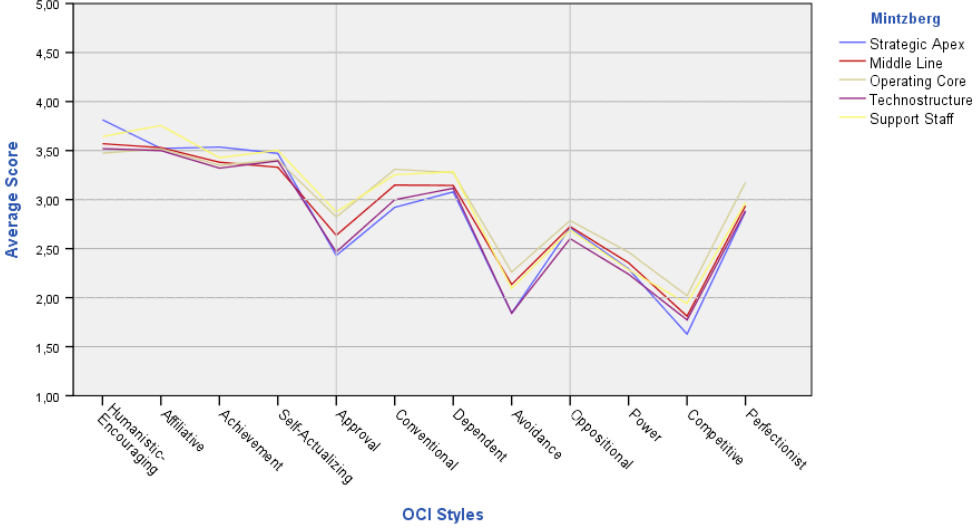
Figure 11. OCI styles averages by Mintzberg’s organizational components.